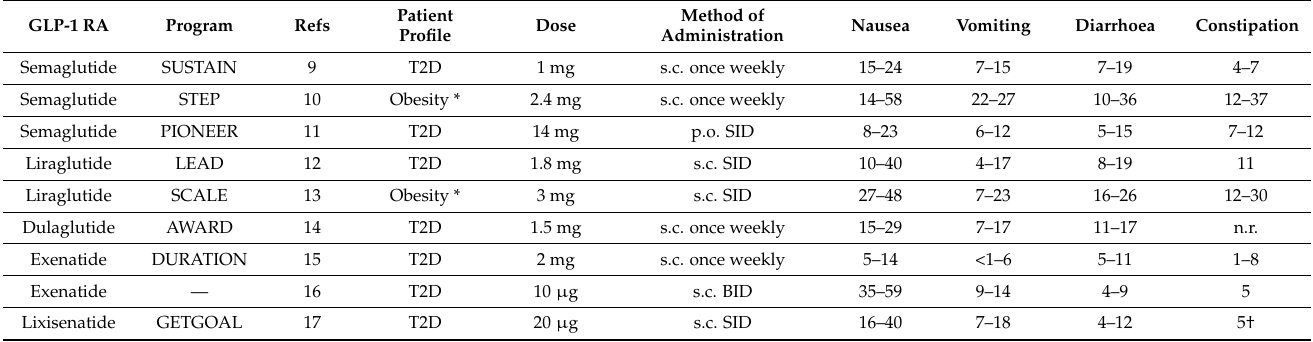
Table 1. Frequency of GI AEs in clinical trials with GLP-1 RA in people with obesity or